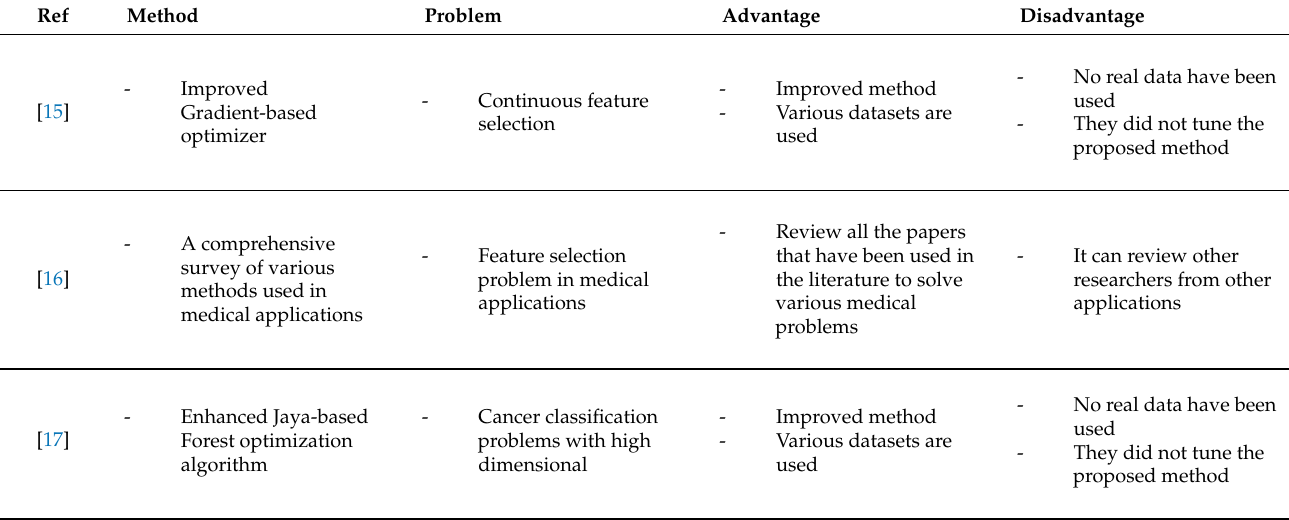
Table 1. An overview of the selected related